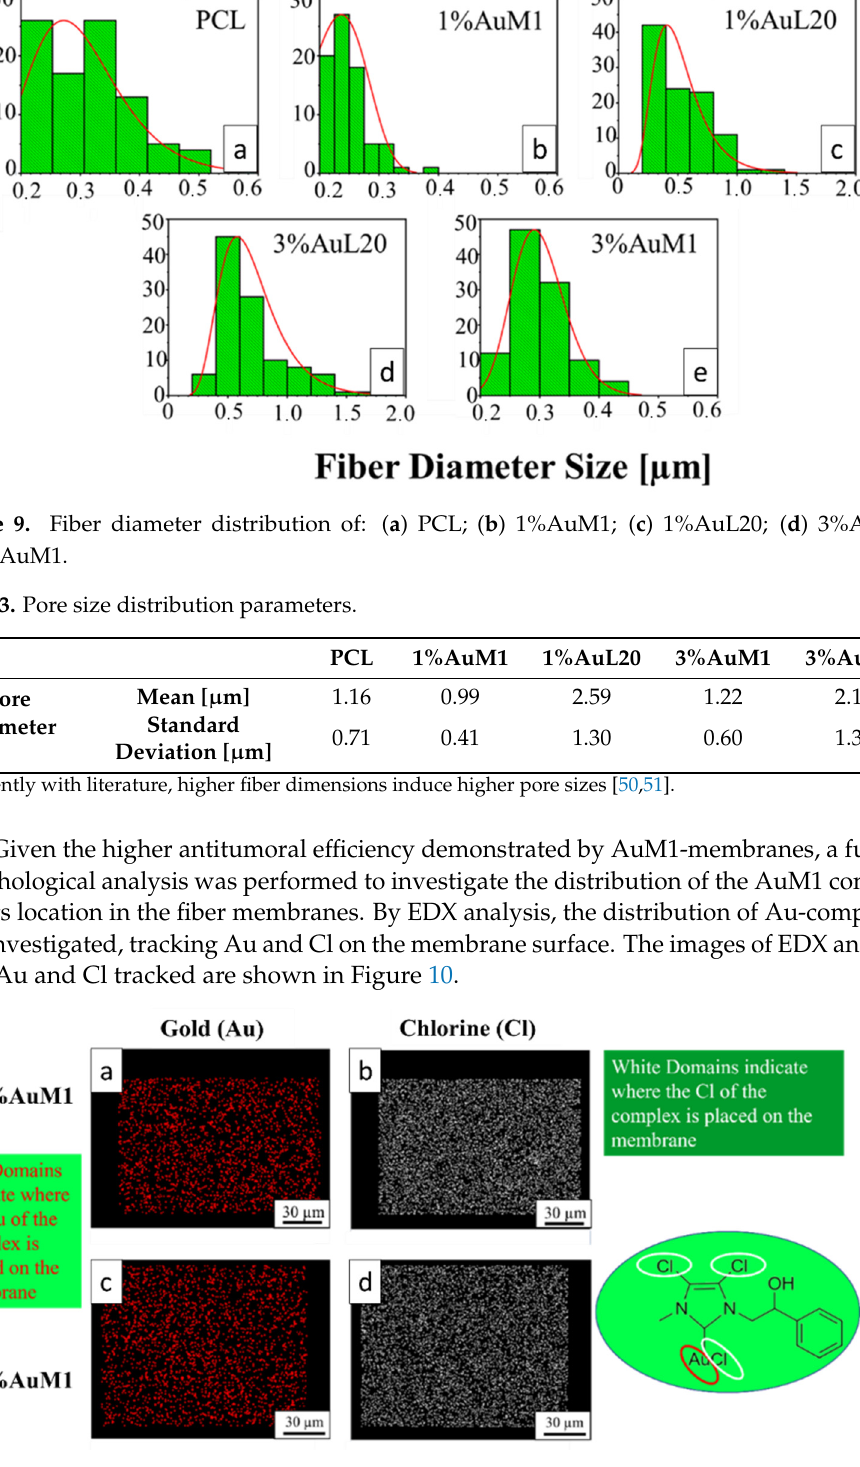
Figure 10. EDX images of 1%AuM1 and 3%AuM1 samples of gold ( a , c ) and chlorine ( b , c ), respec- tively. Images ( a , b ) refer to samples with 1% of the complex, whereas ( c , d ) to samples with 3% of